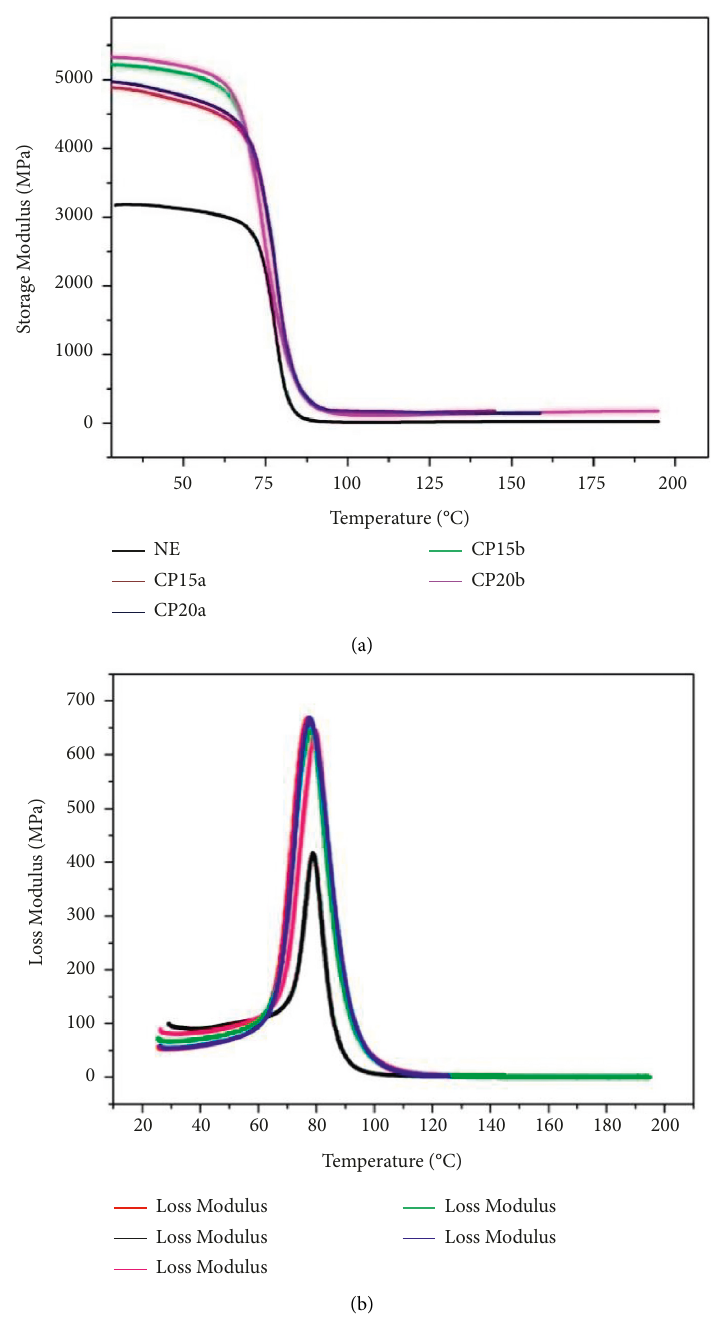
Figure 3: (a) Storage. (b) Loss modulus of different filler ratios of composites,